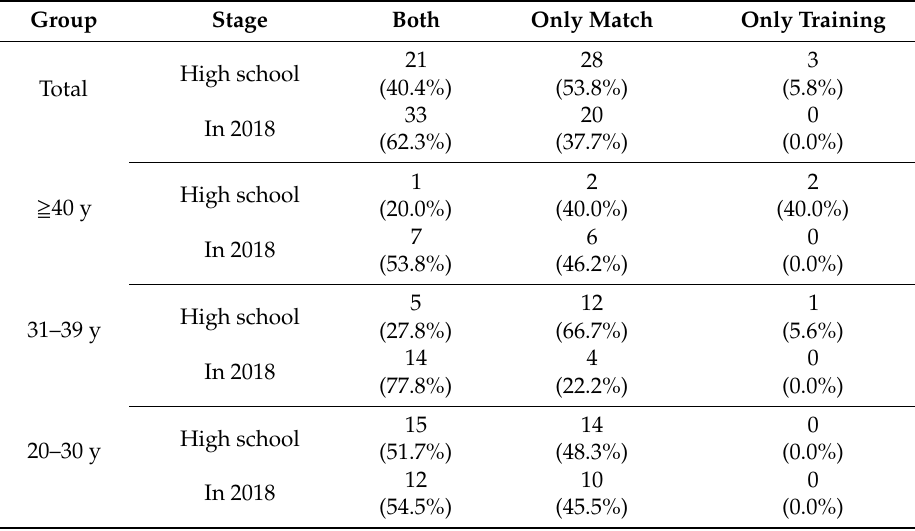
Table 4. MG wearing